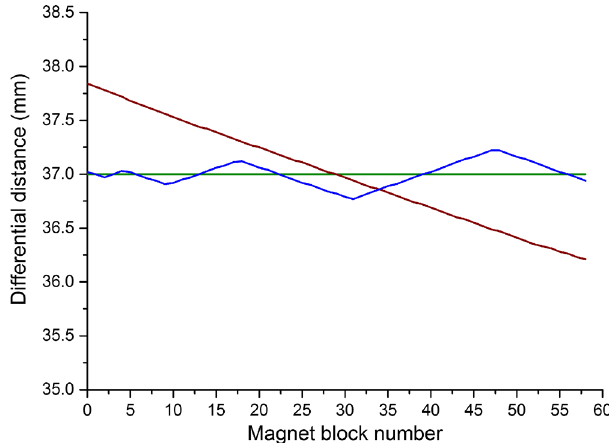
FIG. 13. Distances between centers of nearby magnet blocks after period adjustment from 5.6 to 7.4 cm (red: first step; blue: after 20 iterations; green: ideal magnet positions for period of 7.4 cm).